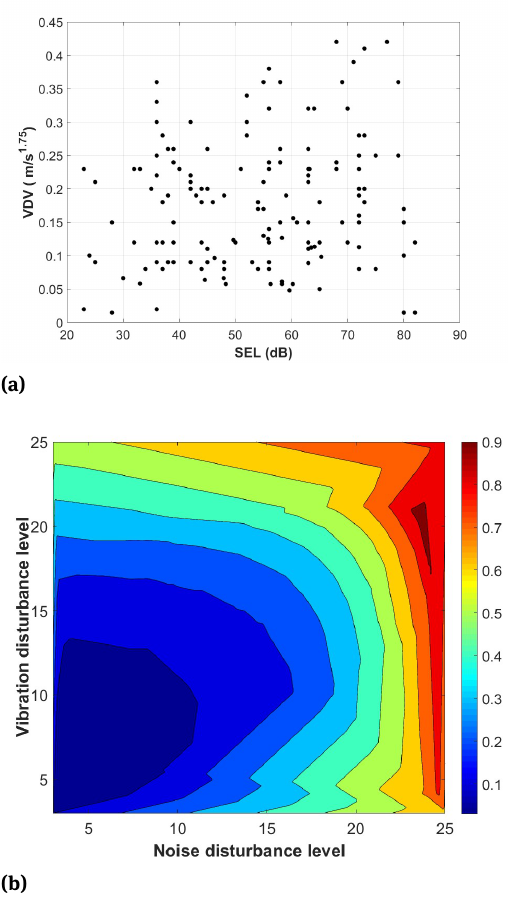
Figure 9: Measurement results, (a) computed VDV versus SEL and (b) disturbance level in respect to noise and vibration disturbance level.